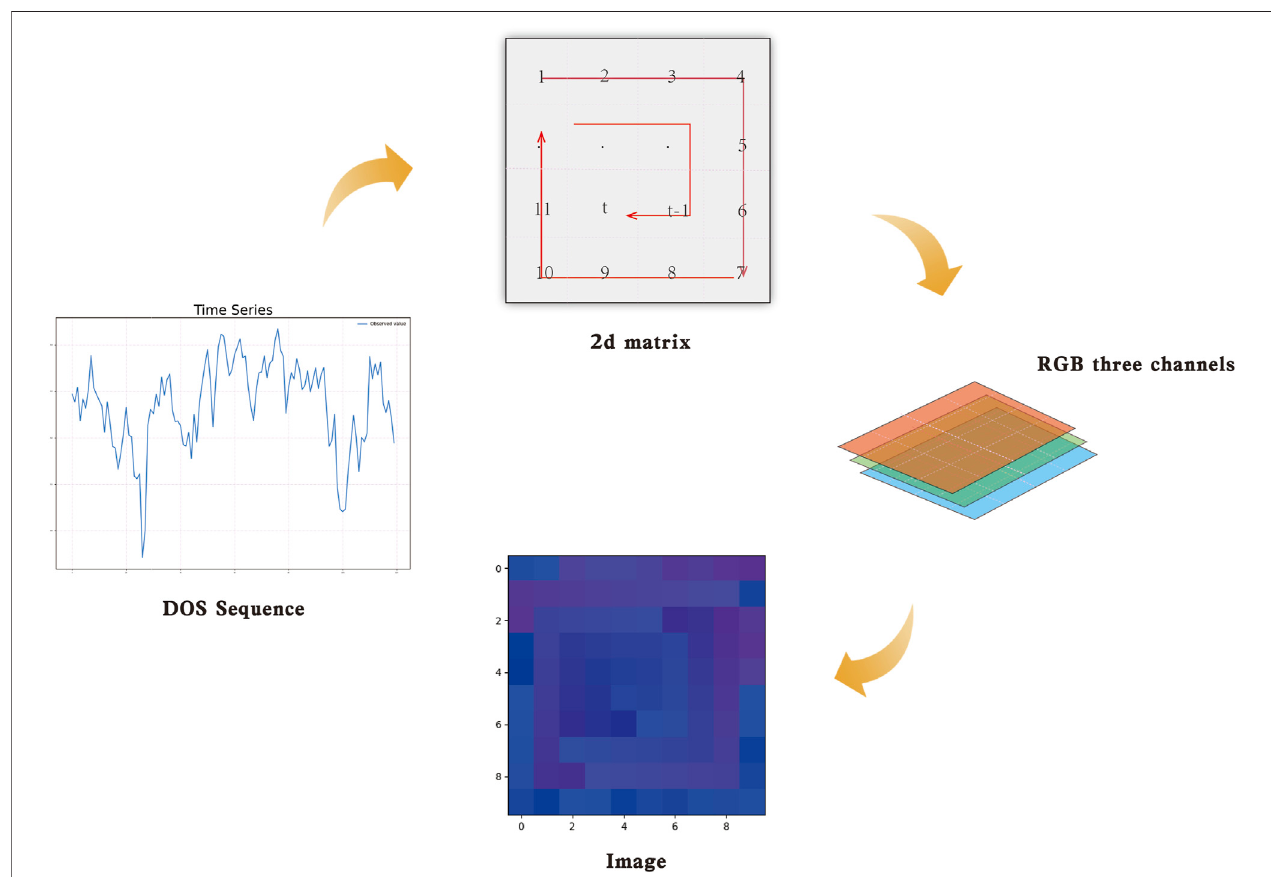
FIGURE 3 | Process of constructing two-dimensional image of DO